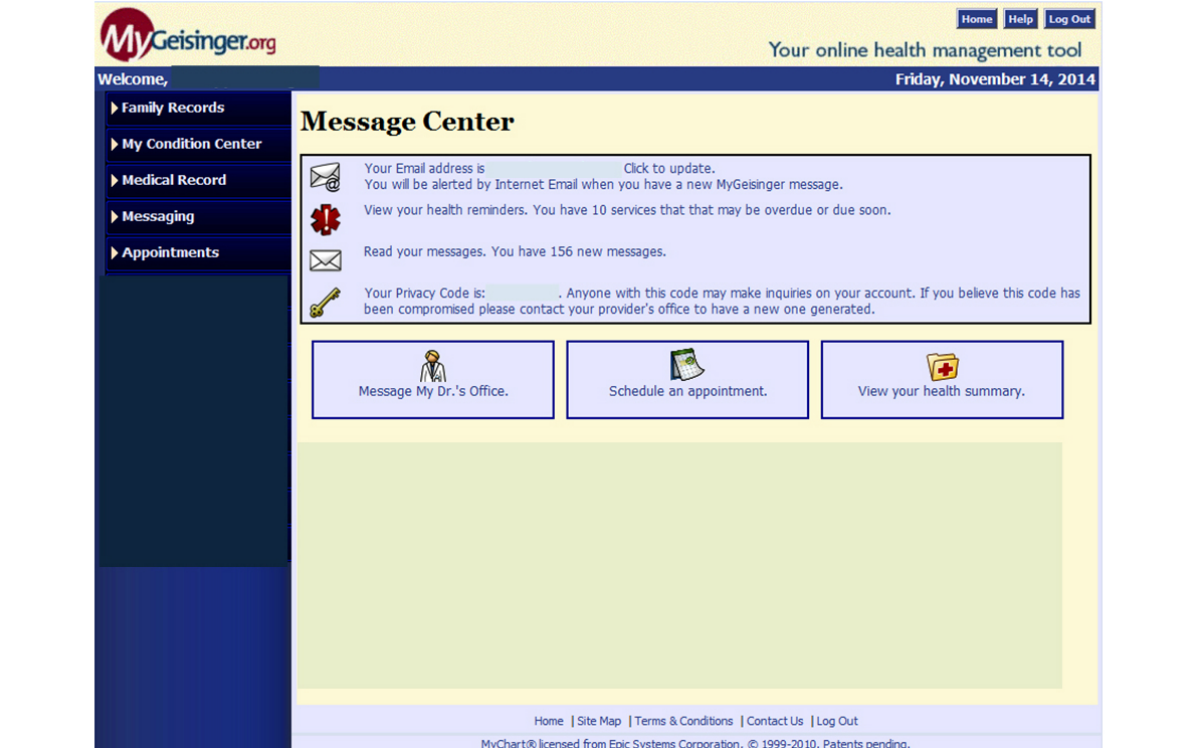
Figure 1. Screenshot of the MyGeisinger Patient